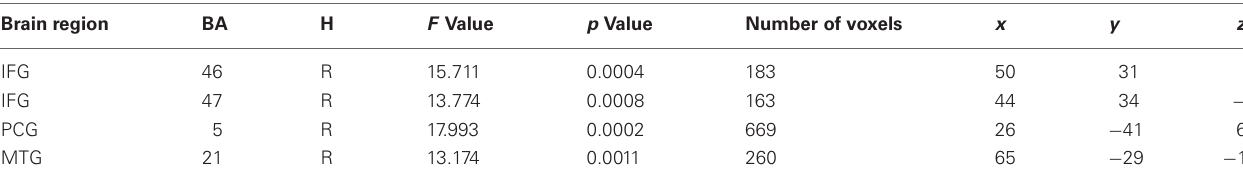
Table 1A | Brain regions activated in the voxel-wise Time by Group Interaction for the auditory transfer task. Brain